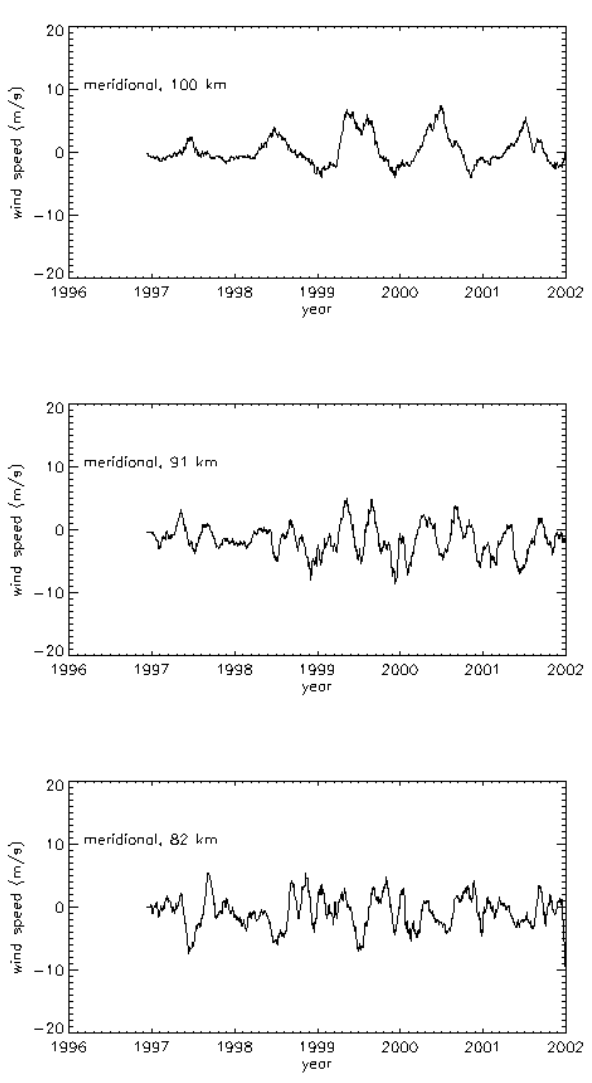
Fig. 8. As for Figs. 2 and 7, but for the meridional